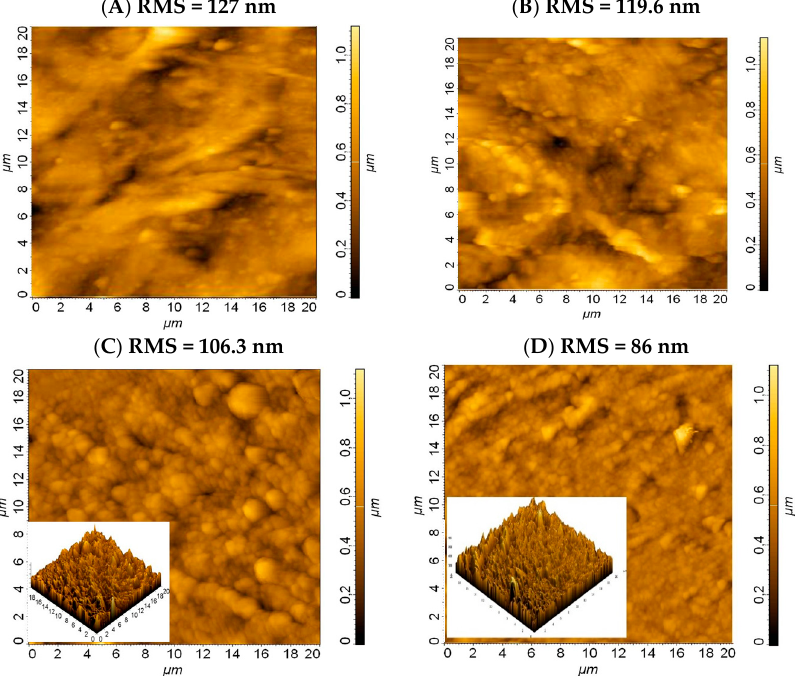
Figure 7. AFM images of 1S_FA—2 before and after water immersion of: (A) 1S; (B) 1S water immersed; ( C ) 1S_FA—2; ( D ) 1S_FA—2 immersed